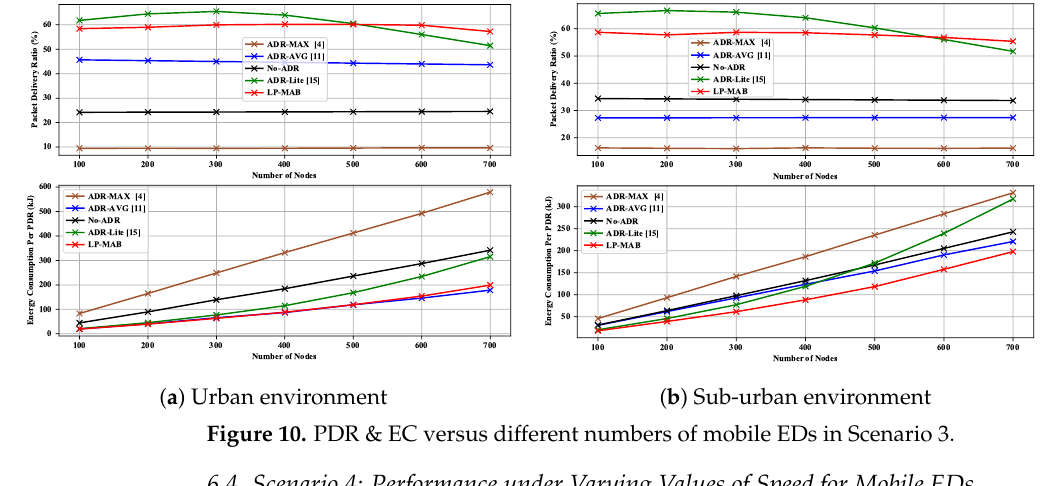
Figure 10. PDR & EC versus different numbers of mobile EDs in Scenario 3.